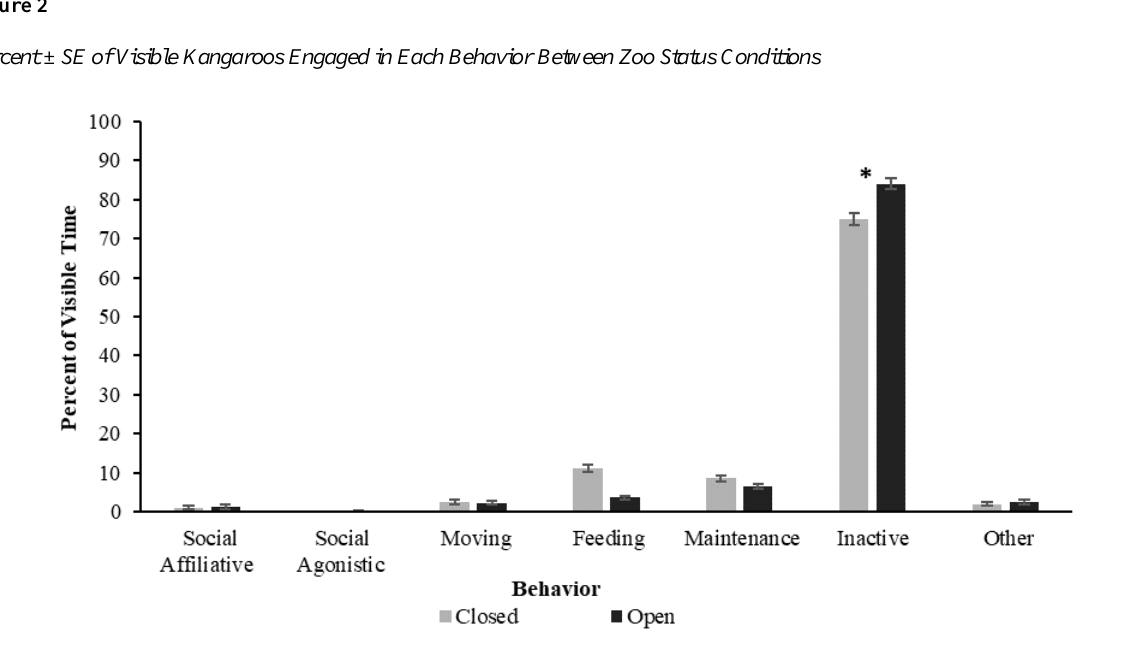
Note . Significant ( p < .05) results are marked with an